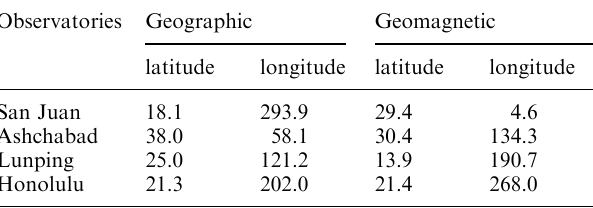
Observatories Geographic